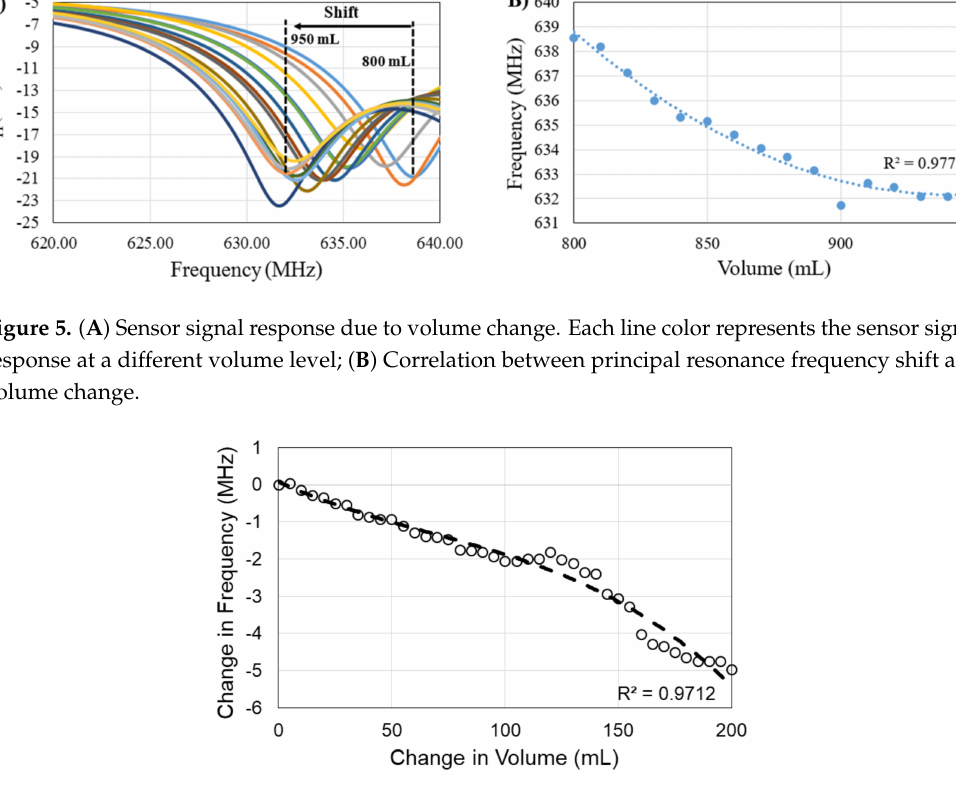
Figure 6. Correlation between principal resonance frequency shift and volume change in the model consisting of the dry human skull and head